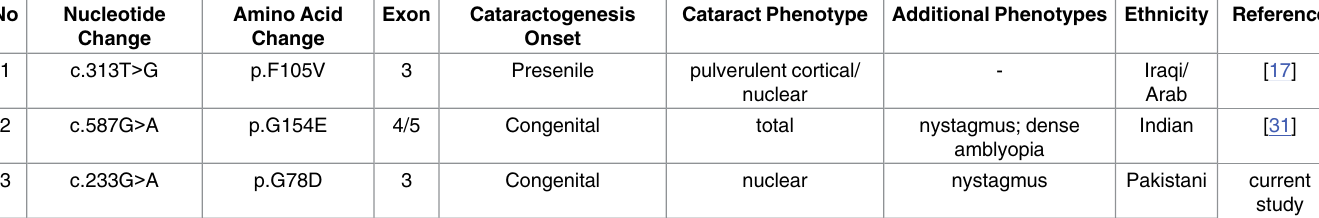
Table 4. Summary of mutations identified in LIM2 associated with cataractogenesis.